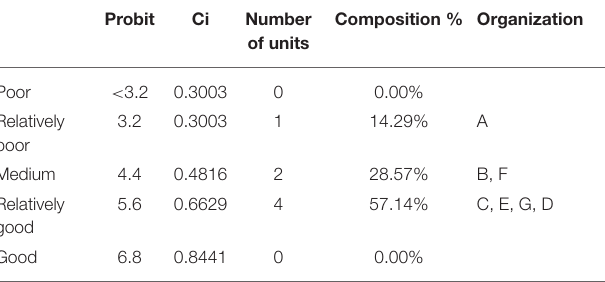
TABLE 7 | Ranking of laboratory management evaluation in terms of